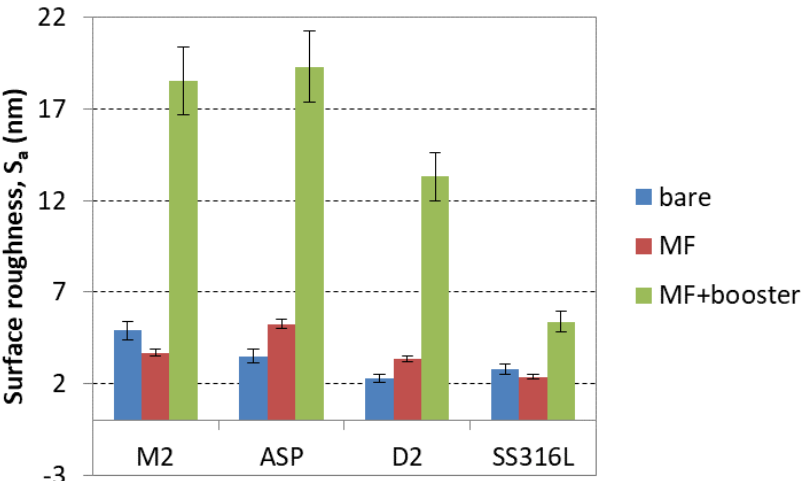
Figure 4. AFM surface roughness of different substrates (M2, ASP, D2, SS 316L) before and after MF and MF + booster ion etching. The scan area was 20 µm × 20 µm.